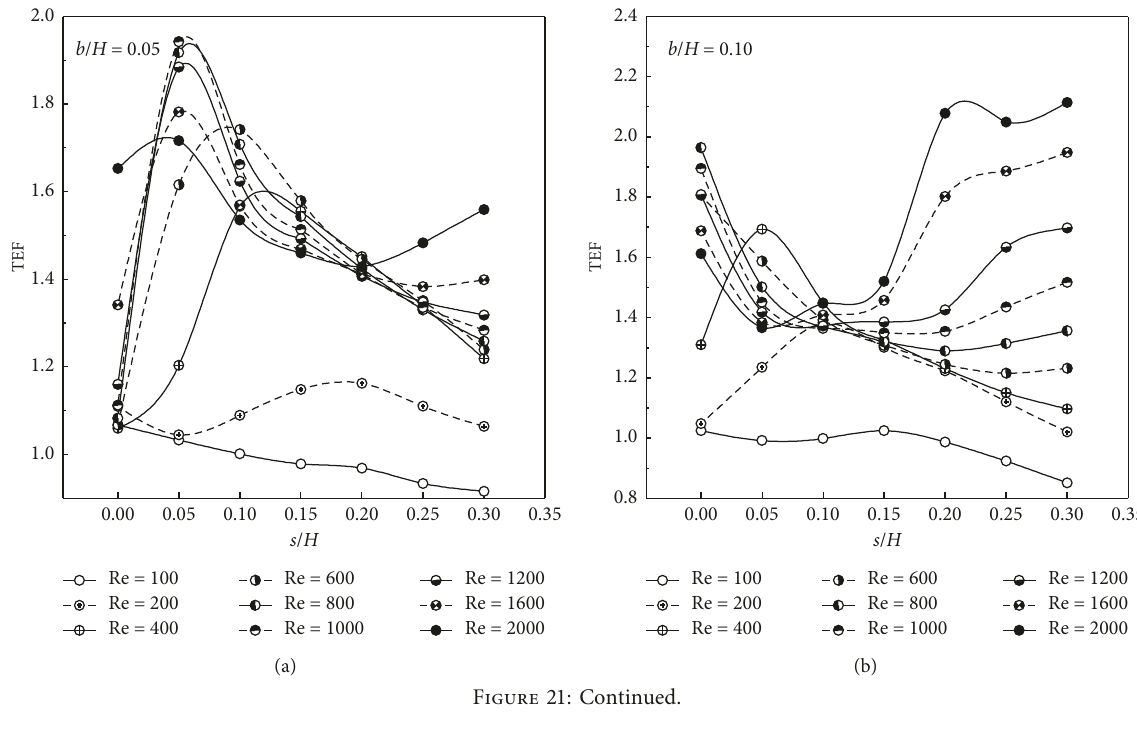
Figure 20: f / f 0 versus s / H for the heat exchanger square duct installed with the 45 H 0.20, (e) b / H 0.25, and (f) b / H (cid:31) (cid:31)